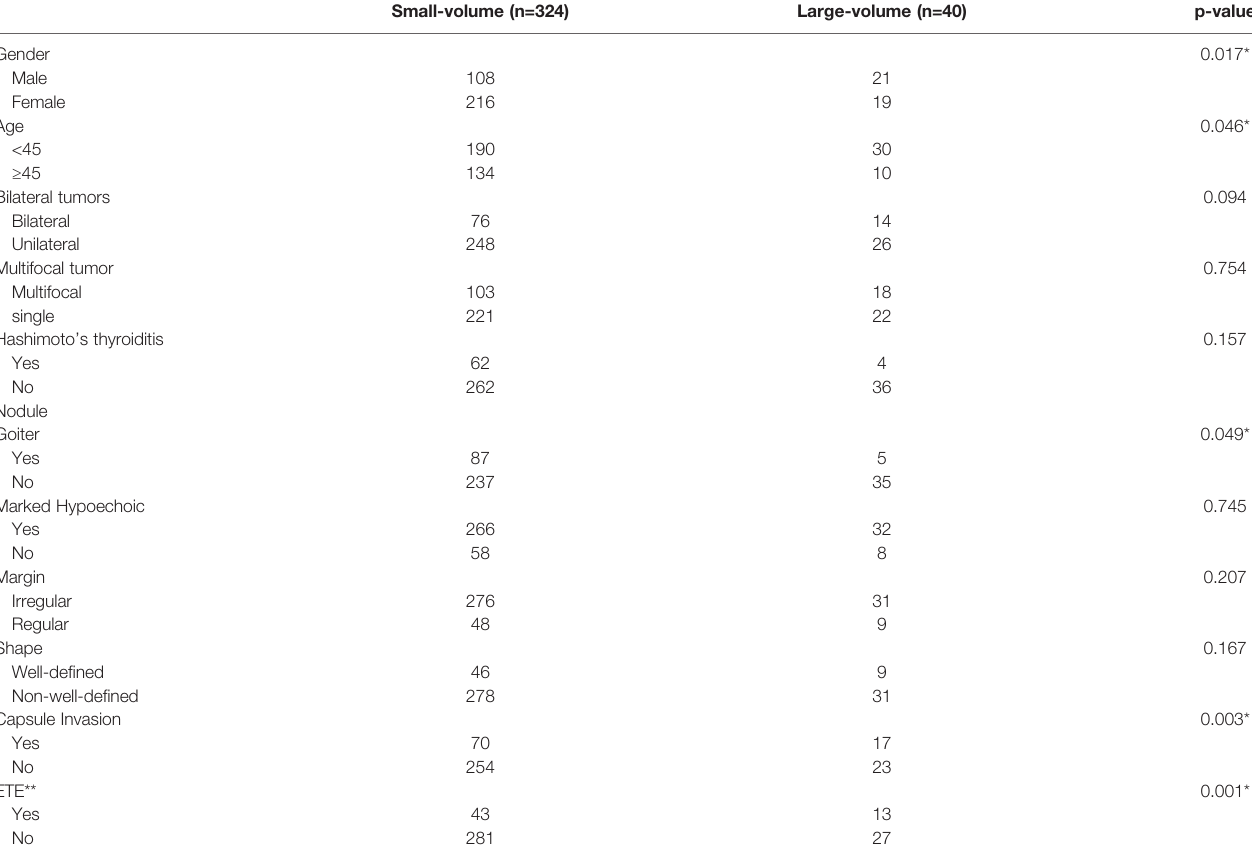
TABLE 1 | Clinicopathological characteristics and univariate analysis of PTC patients (n=364).